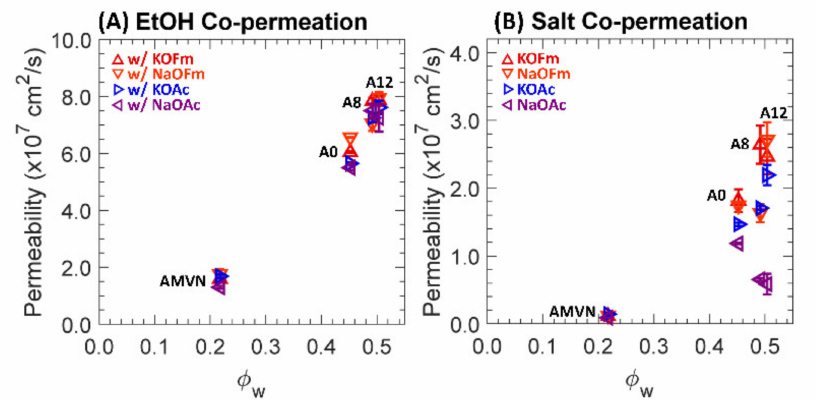
Figure 6. ( A ) Permeabilities to EtOH in co-permeation with KOFm ( (cid:52) , red), NaOFm ( (cid:53) , orange), KOAc ( (cid:46) , blue) and NaOAc ( (cid:47) , purple). ( B ) Permeabilities to KOFm ( (cid:52) , red), NaOFm ( (cid:53) , orange), KOAc ( (cid:46) , blue) and NaOAc ( (cid:47) , purple) in co-permeation with EtOH. Each data point is the average of 3 experiments, with error bars corresponding to the standard